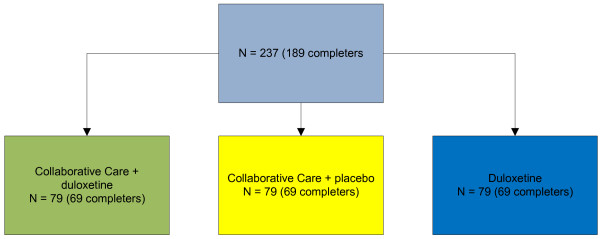
Treatment options.